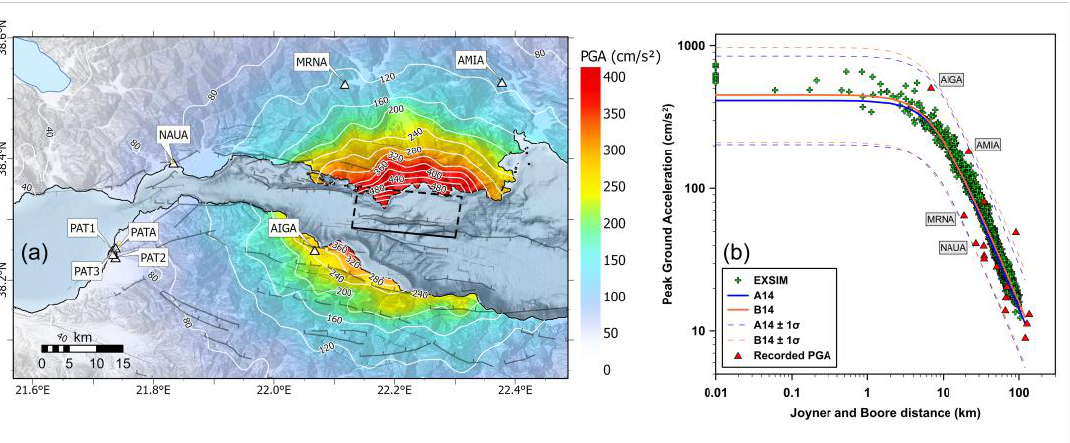
Figure 6. ( a ) Spatial distribution of simulated PGA values (cm/s 2 ) calculated with the EXSIM code for the case of the Aigion 1995 mainshock. ( b ) Comparison between the recorded (red triangles), GMPE-derived (lines), and simulated (crosses) PGAs, plotted as a function of the Joyner and Boore distance (R jb ). The simulated values on the surface projection of the fault plane (R jb = 0) were assigned a very small positive R jb value (~0.01 km) to make them visible on the logarithmic axis.